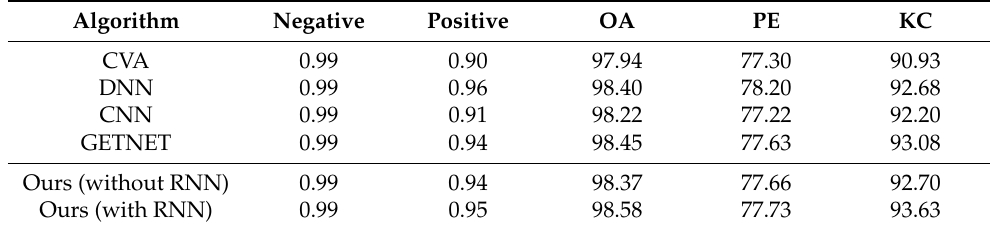
Table 2. Quantitative evaluation of experimental results of different methods on Hermiston City Area